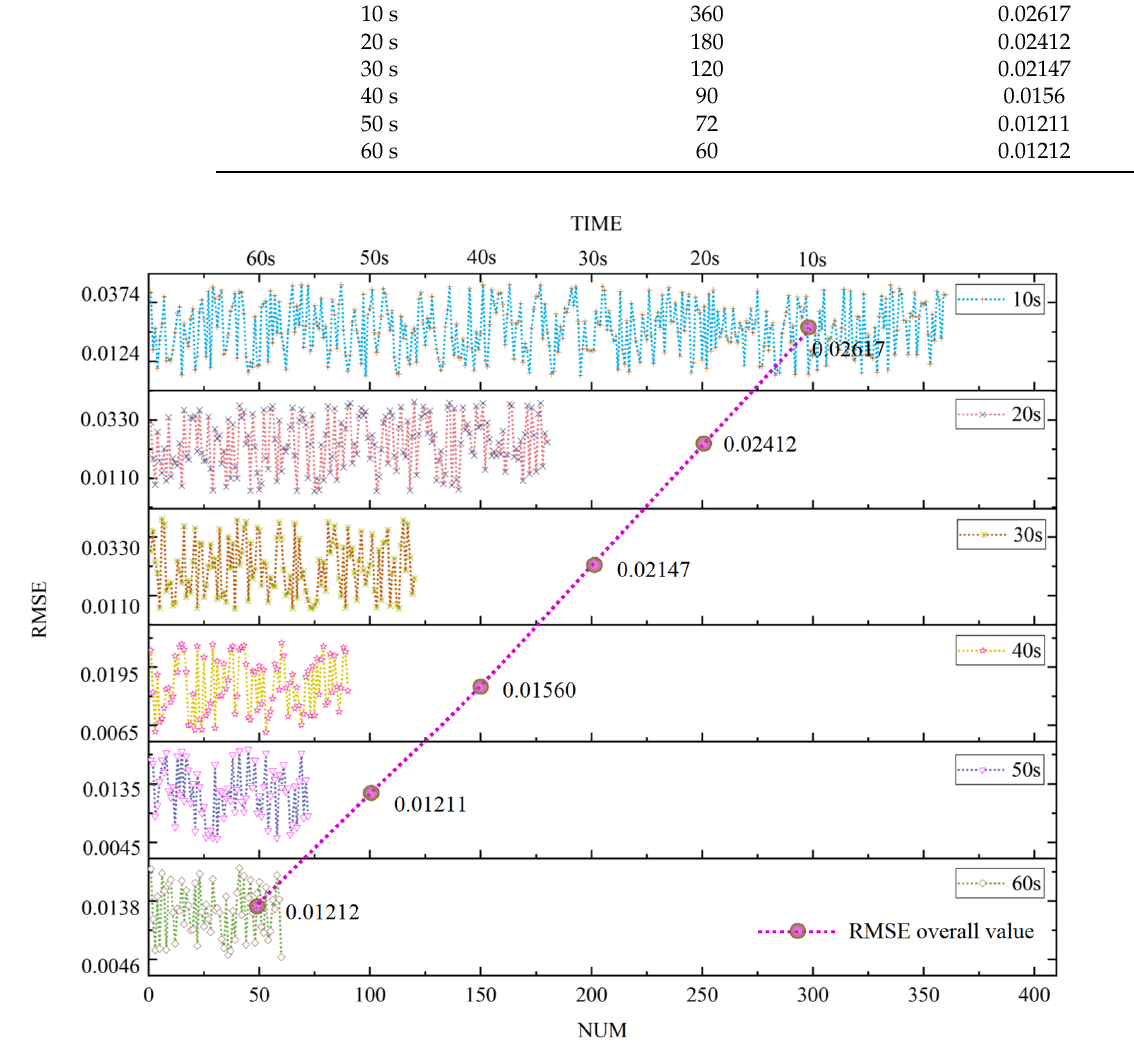
Figure 13. Changes in the RMSE of the model under different update cycles. Table 2. The overall value of the RMSE of the model under different update cycles.